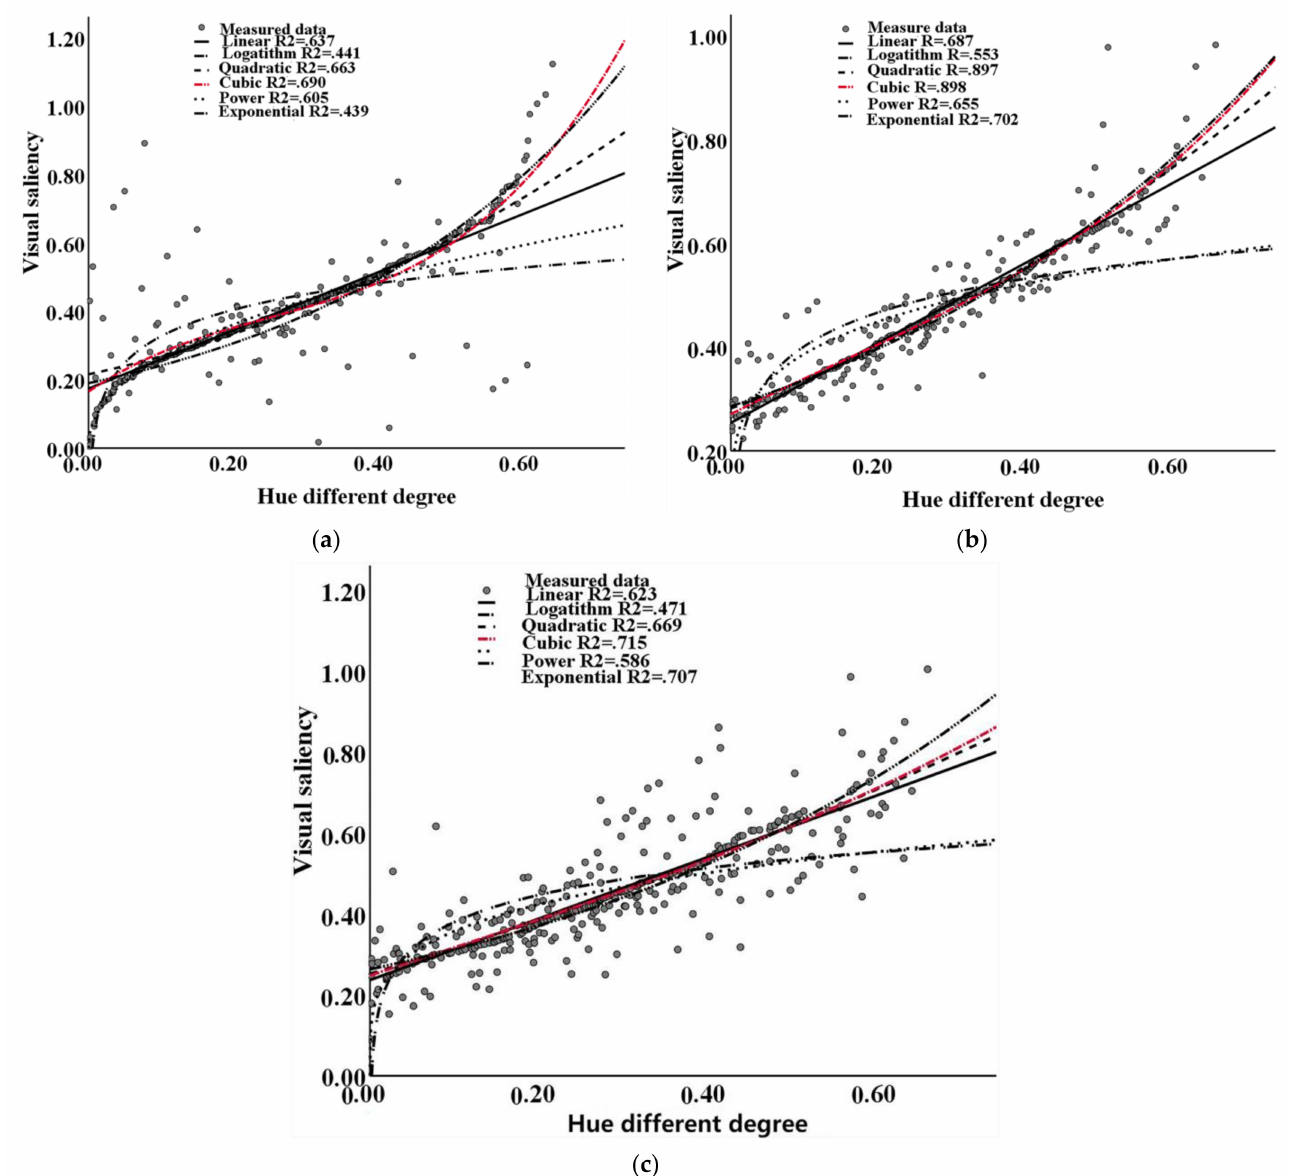
Figure 5. As show in the figure, the hue different degree and visual saliency curve fitting graph, where R 2 represents the Pearson Goodness of Fit Statistic. (( a ) is for Experiment 2.1, ( b ) is for Experiment 2.2, ( c ) is for Experiment